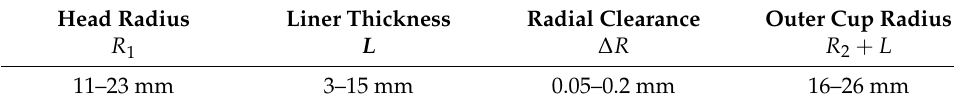
Table 1. Geometrical properties in THA [13,26,27].